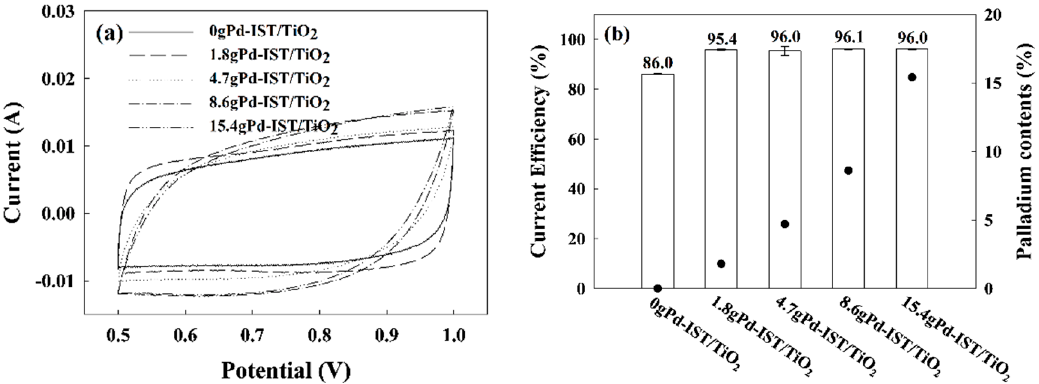
Figure 2. ( a ) CVs for Pd-based electrodes of different palladium loading weights with sweep rates from 100 mV/s in 3M of H 2 SO 4 solution; ( b ) Comparison of current efficiency (left bar) and palladium contents (right bar, dots) at different palladium contents.